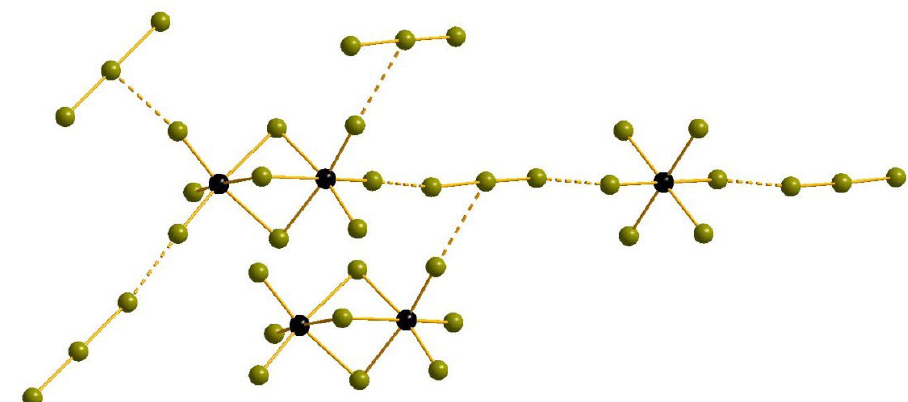
Figure 1. Br···Br non-covalent interactions in the structure of 1 . Here and below: Se, black; Br, olive-green; non-covalent contacts, dashed.